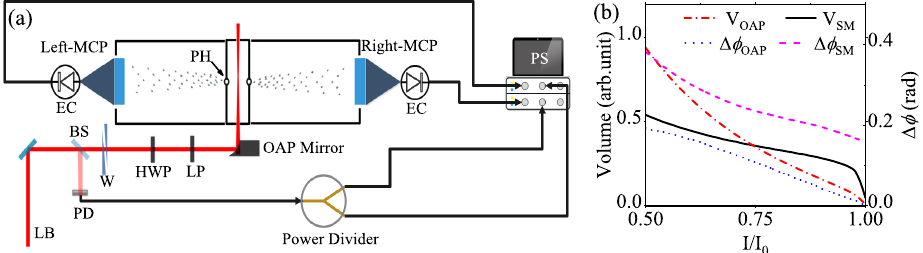
Figure 1. ( a ) Schematic view of the experimental setup. Laser beam (LB) with polarization along the horizontal direction is introduced into the sample chamber by a off-axis parabolic (OAP) mirror. The photoelectrons produced at the laser focus fly towards left and right MCP detectors through two pinholes (PH). The signals recorded by the MCP detectors are extracted by two homemade electronic circuits (EC). The photoelectron signals are sent to a PXI system (PS) equipped with a pair of fast digitizers. By a beam splitter (BS), a small portion of laser is directed and detected by a photo-diode (PD). The PD output is further split evenly by a power divider to trigger the PS and perform intensity tagging. A pair of fused silica wedges (W) are applied to compensate the residual positive chirp of the laser beam. A combination of an achromatic broadband half-wave plate (HWP) and a commercial (Edmund #36-652) linear polarization (LP) is applied to alter the laser intensity. See text for more details. ( b ) The intensity dependence of the CEP range ( ∆ φ ) and volume ( V ) of each iso-intensity shell of few-cycle laser pulses focused by an OAP mirror and a spherical mirror (SM),